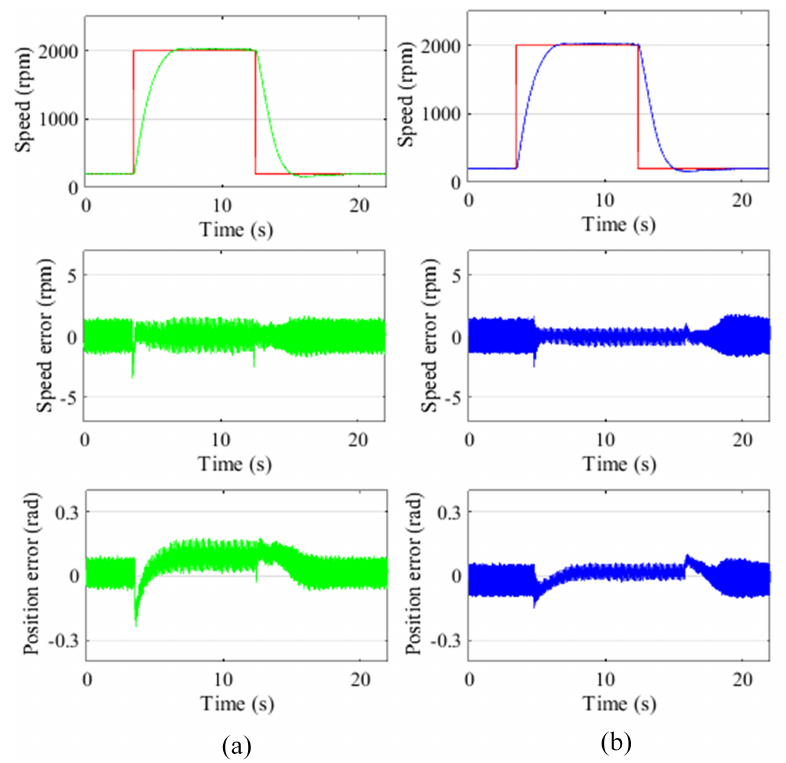
Figure 6. The speed changes from 100 rpm (0.05 p.u.) to 2000 rpm (1 p.u.): ( a ) conventional method; and ( b ) proposed method. “Red Line” represents the reference signals, “Green Line” represents the signals that are achieved by using convention method and “Blue Line” denotes the signals that are obtained by using the proposed